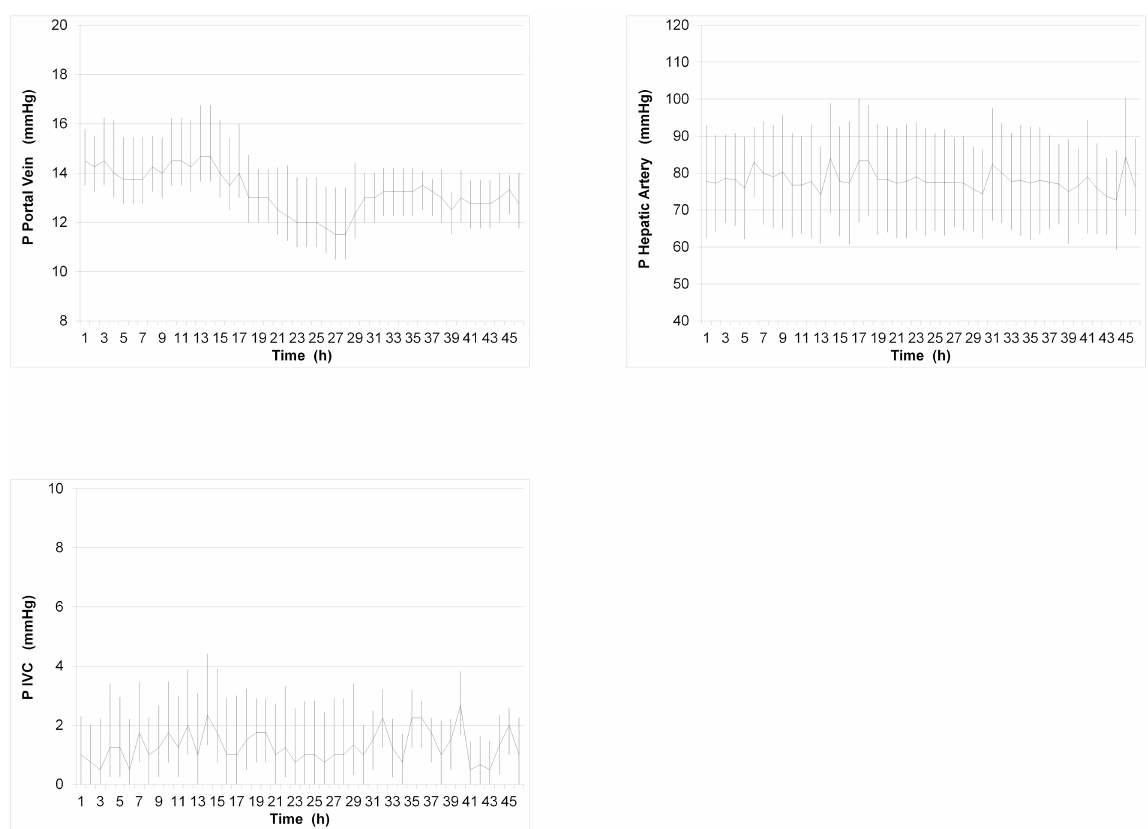
Fig 3. Mean pressures during 46 hours of normothermic perfusion. Control was achievedby regulation of pump speedand inflow to portal venous blood reservoir to keep values within physiologic range. Portal pressurewas based on the principleof autoregulation. (A) Portal pressure ± SD, (B) Arterial pressure ± SD, (C) IVC pressure ± SD. All pressureswere measuredin-line showinglittle variation betweenlivers. (n =